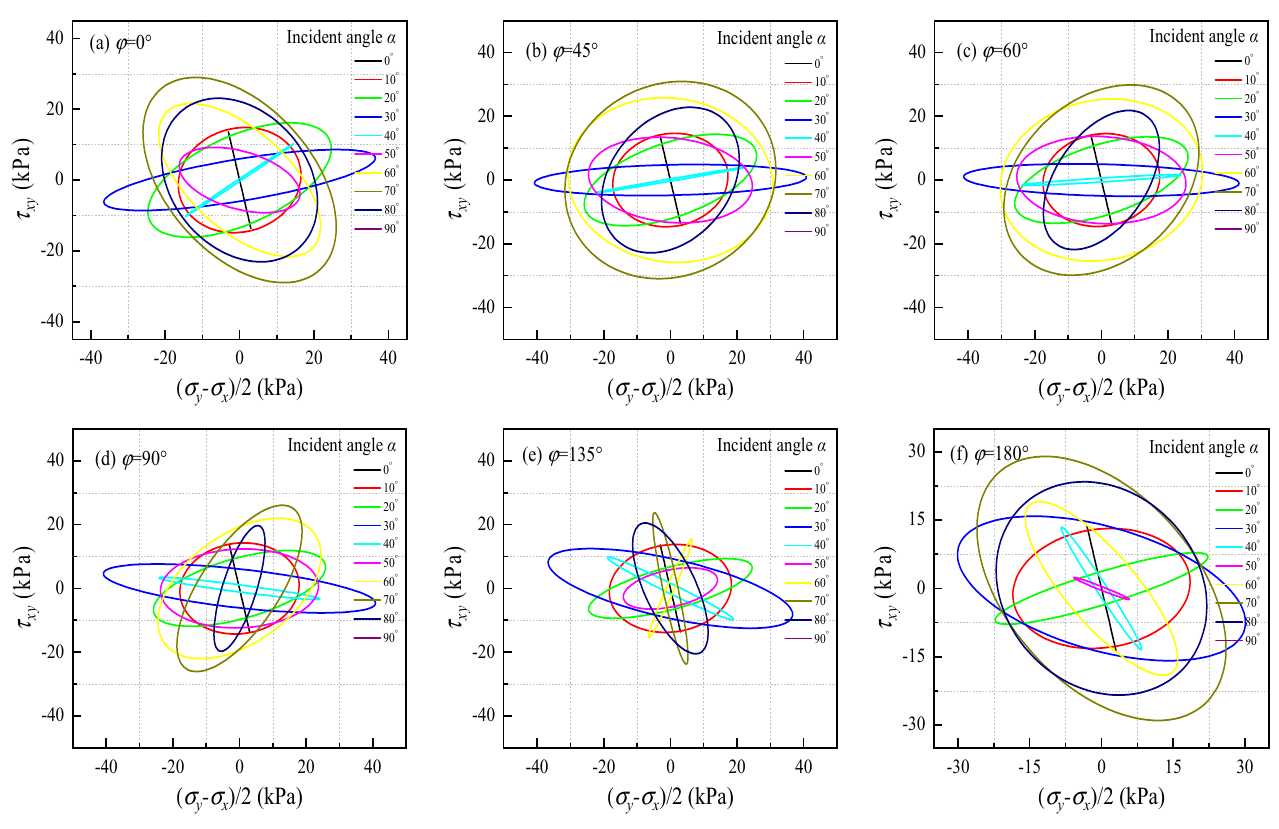
Figure 11. Variation of characteristic parameters of elliptical stress path with the incidence angle for various phase differences.